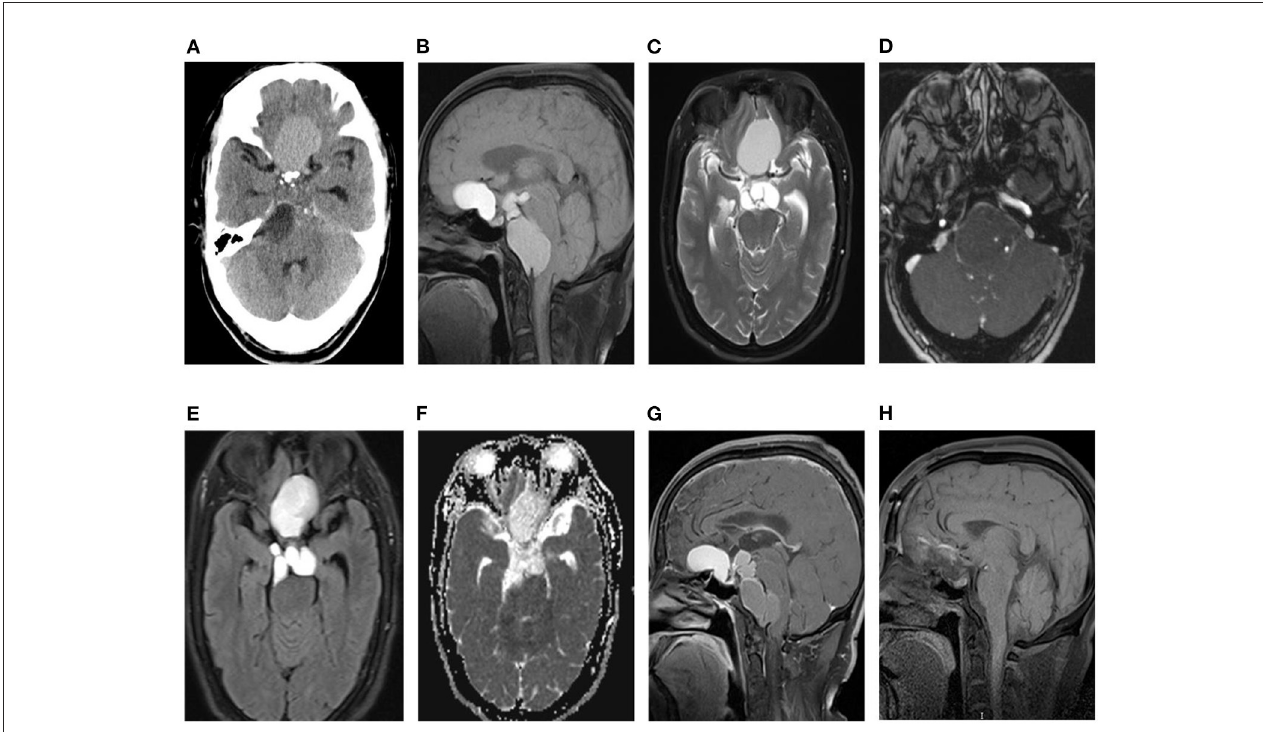
FIGURE1 (A) Axial CT without contrast in the cerebral window reveals craniopharyngiomas in the anterior, medial, and posterior fossa, with slightly high density in the anterior fossa, slightly low density in middle fossa, low density in the posterior fossa, and small high-density calcifications at the margins of middle fossa tumors. (B, C) The anterior, middle, and posterior cranial fossa tumors show multilocular cysts, the anterior cranial fossa tumor shows hyperintense on T1WI (B) and T2WI (C) , and the middle and posterior cranial fossa tumors show equal signal on T1WI and T2WI. (D) MRA shows that the tumor in the posterior fossa surrounds the right vertebral artery. (E) FLAIR show mixed hyperintense in the anterior cranial fossa mass and hyperintense in the middle and posterior cranial fossa masses. (F) ADC does not show a restricted diffusion hypointense. (G) The sagittal T1WI shows no enhancement of the anterior cranial fossa tumor, wall enhancement of the middle and posterior cranial fossa tumors, and no enhancement in the center of all tumors. (H) Postoperative sagittal MRI showed that the tumor had been